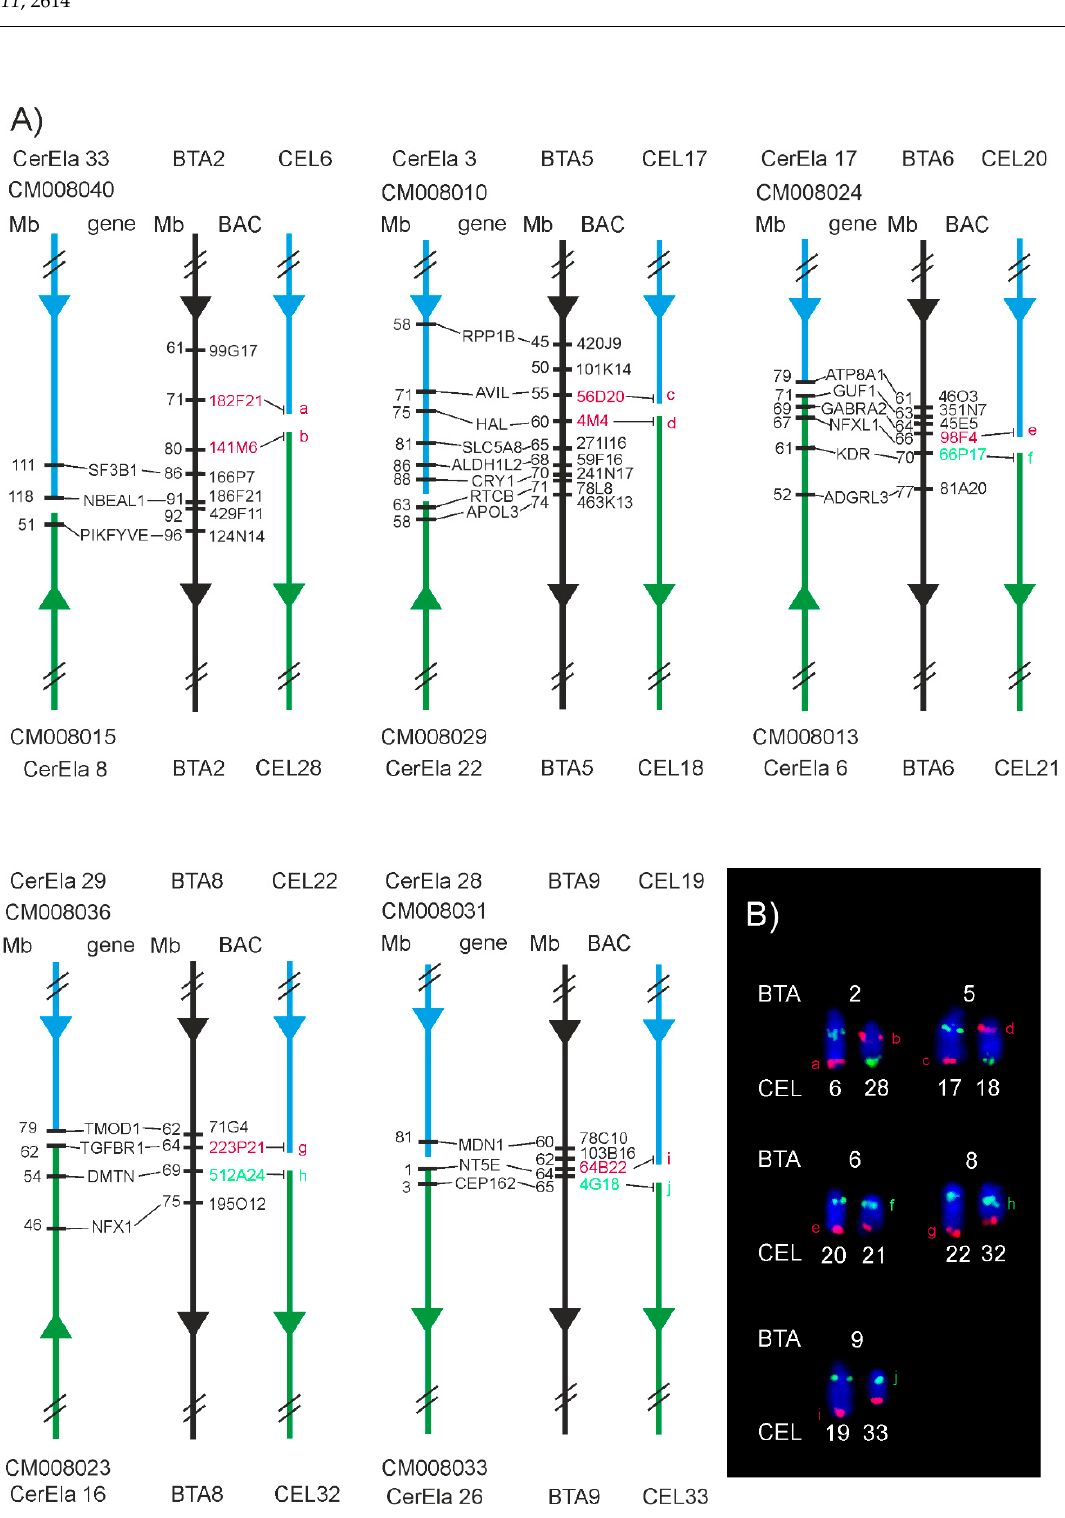
Figure 4. Evolutionary breakpoints on BTA2, 5, 6, 8 and 9 orthologues. ( A ) Schematic presentation of the CerEla1.0 C- scaffolds and BTA and CEL chromosomes with indicated positions of BAC clones used for the verification of the breakpoint positions. The BAC gene content and the position of the genes on the CerEla1.0 C-scaffolds is also shown. Notice differences in the assumed breakpoint positions on the CerEla1.0 C-scaffolds and the positions of breakpoints detected by FISH on the red deer chromosomes. ( B ) BAC-FISH signals at proximal, breakpoint and distal positions on C. elaphus chromosomes orthologous to BTA2, 5, 6, 8 and 9. Positions of selected BAC probes indicating the approximate evolutionary breakpoints are marked by letters (a–j): a—182F21, b—141M6, c—56D20, d—4M4, e—98F4, f—66P17, g—223P21, h—512A24, i—64B22, j—4G18. The unmarked FISH signals correspond to the proximal (green); and distal (red) BAC